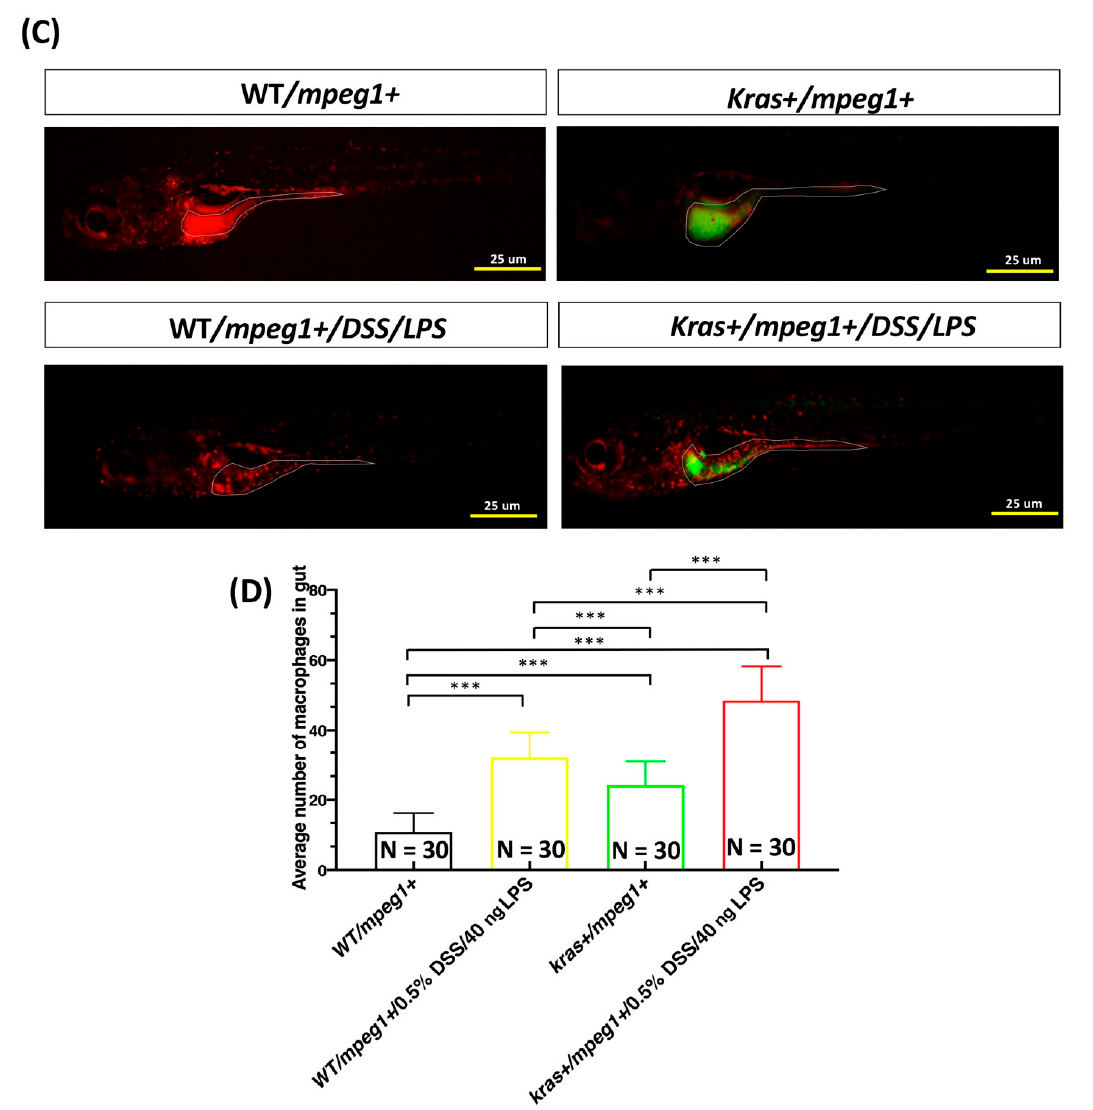
Figure 6. Cotreatment with DSS and LPS exacerbated the increased number of neutrophils and macrophages in the intestines of kras+/lyz+ and kras+/mepg1+ zebrafish. ( A , C ) Fluorescence of neutrophils (WT/lyz+, n = 30; WT/lyz+/DSS/LPS, n = 32; kras+/lyz+, n = 31; kras+/lyz+/DSS/LPS, n = 31) or macrophages (WT/mpeg1+, n = 30; WT/mepg1+/DSS/LPS, n = 30; kras+/mpeg1+, n = 30; kras+/mepg1+/DSS/LPS, n = 30) in the intestines. ( B , D ) Quantification of the number of positive cells as revealed by fluorescence of neutrophils or macrophages. Differences among the variables were assessed using Student’s t-tests. Statistical significance: *** p < 0.001. Scale bar: 25 μ m.